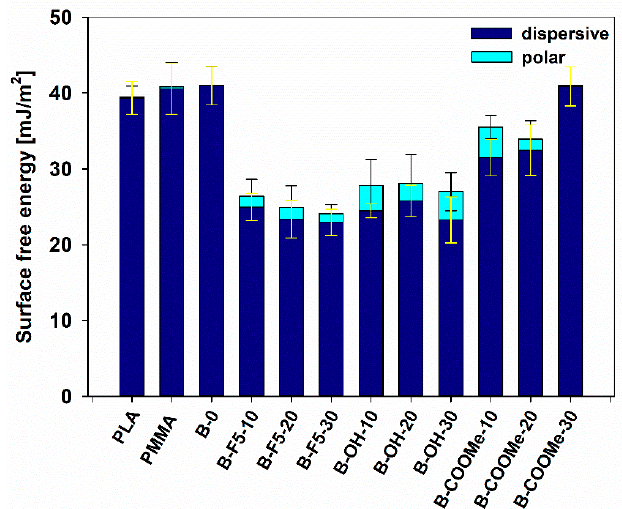
Figure 12. Changes of surface energy measured for native PLA, PMMA, their blend B-0 and blends with LPSQ-R.